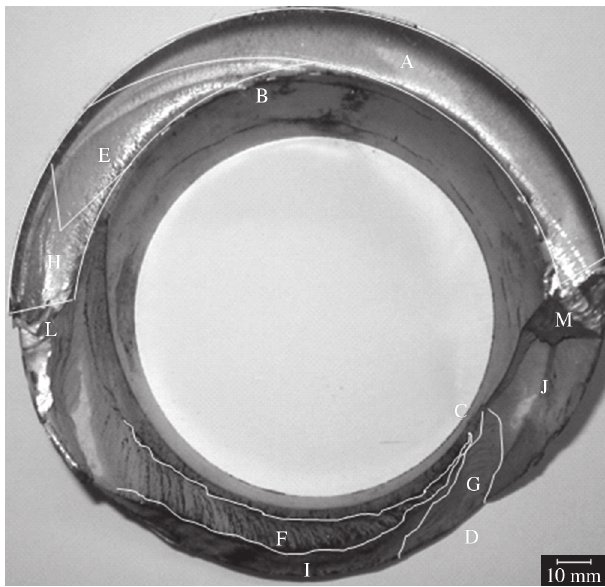
Figure 11. Visual inspection of drill pipe DPA01.